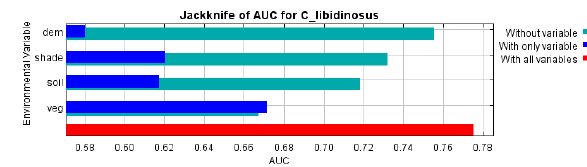
Figure 4. Jackknife plot of variable importance in the MaxEnt model of bearded capuchin movement. Dark blue bars represent the AUC value of the model using only the variable listed to the left. Light blue bars represent the AUC value of the model without the variable of interest. The final red bar shows the AUC of the complete model, including all